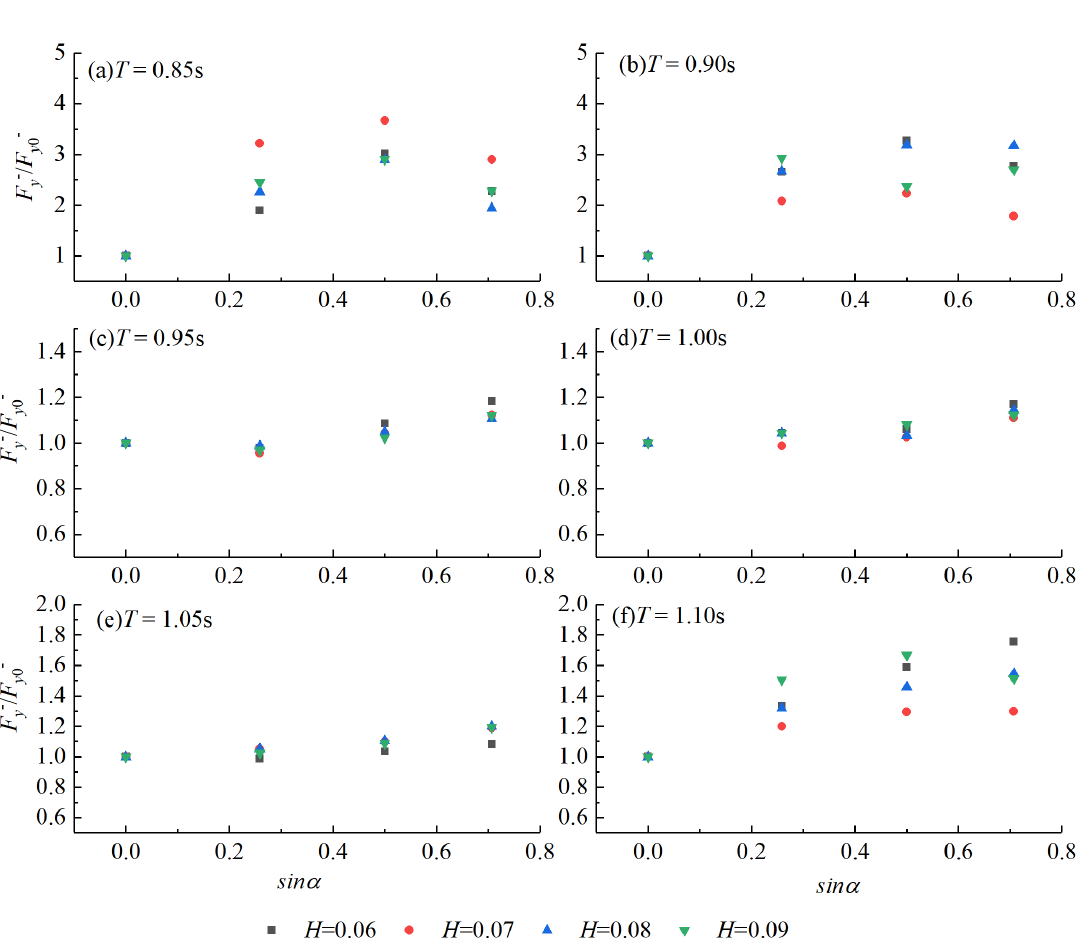
Figure 14. The wave directionality effect on the transversal negative peak force for the conditions of ( a ) T = 0.85 s, ( b ) T = 0.90 s, ( c ) T = 0.95 s, ( d ) T = 1.00 s, ( e ) T = 1.05 s, ( f ) T = 1.10 s.